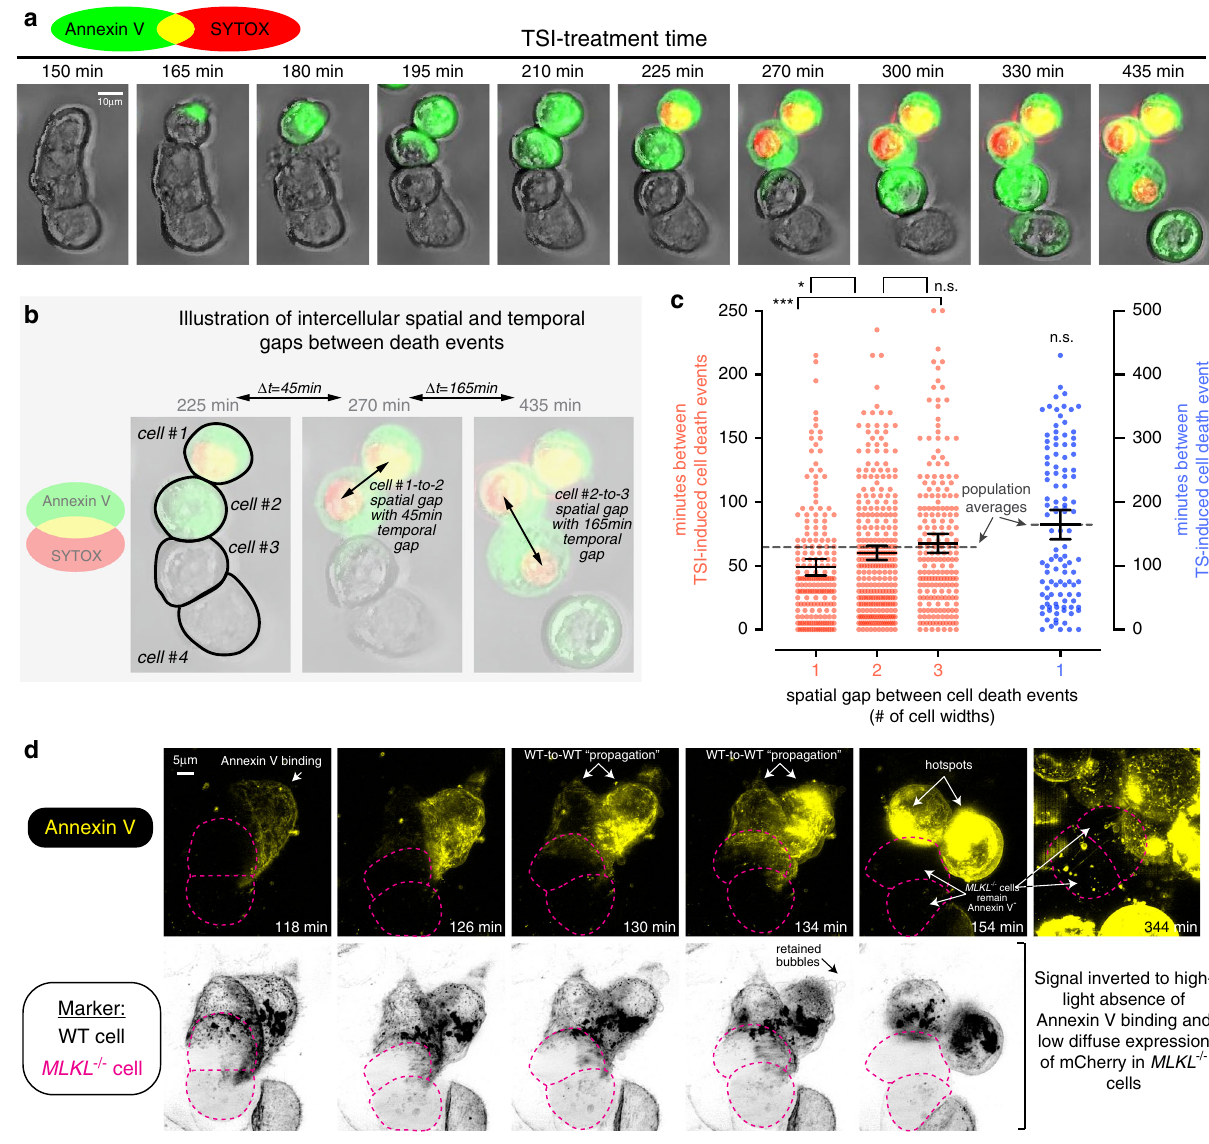
Fig. 5 Necroptosis is accelerated between junctioned epithelial cells. a HT29 cells were TNF, Smac mimetic and IDN-6556 (TSI)-treated, then Annexin V-binding (green) and SYTOX Green-uptake (red) were imaged via time-lapse epi fl uorescence microscopy. b, c HT29 cells were treated with TSI (necroptotic stimulus) or TS (apoptotic stimulus), then propidium iodide-uptake (death) and subsequent movement of dead cells was tracked over time using the IncuCyte S3 System. d Each dot represents the spatiotemporal gap between two cell death events. Mean ± 95% con fi dence intervals; dashed line represents the average spatiotemporal gap between all cell death events across the population; n.s . p = 0.2223, * p = 0.0422 and *** p = 0.0006 via one- way ANOVA with Tukey ’ s correction for multiple comparisons. For TSI-treated HT29 cells: N = 188, 289, 298 gaps for the respective 1, 2, 3-cell-width groups and N = 22676 gaps for the whole population. For TS-treated HT29 cells: N = 110 gaps for 1-cell-width group and N = 17838 gaps for the whole population. e Co-cultures of TSI-treated wild-type (expressing mTagRFP-Membrane-1 fusion protein) and MLKL − / − (diffuse expression of mCherry) HT29 cells were imaged via time-lapse lattice light sheet microscopy (LLSM) with staining for Annexin V-binding (top row; yellow signal) and markers (bottom row; same as top row but with inverted signal). MIP micrographs are representative of N = 7 MLKL − / − cells across n = 3 independent experiments. TSI- treatment times are shown; magenta lines demarcate MLKL − / − cell Tight junction proteins and MLKL are co-traf fi cked . To deduce MLKL pS358 and three tight junction markers: JAM-A, occludin and the nature of the membrane-associated MLKL pS358 puncta and ZO-1 (Fig. 8a and Supplementary Fig. 4b). Colocalization between hotspots that form during necroptosis, we co-stained HT29 cells MLKL pS358 and tight junction markers was also observed in undergoing necroptosis for MLKL pS358 and various junction, HCC2998 cells undergoing necroptosis (Supplementary Fig. 4c). organelle or microdomain markers. Negligible colocalization was Strikingly, ZO-1 colocalized with MLKL pS358 both at hotspots and intracellular puncta, suggesting that MLKL is co-traf fi cked with observed between MLKL pS358 and markers of desmosomes (Des- moglein-2), adherens junctions (E-cadherin), endosomes and tight junction proteins to the plasma membrane during necroptosis caveolae (Flotillin-1), mitochondria (TOMM20), lysosomes in HT29 cells (Fig. 8a). Furthermore, this colocalization was (LAMP2), proteasome (20S) or the chaperone HSP90 39 (Supple- quantitative in nature, with pixel-level proportionality observed mentary Fig. 4a). However, colocalization was evident between between the MLKL pS358 and ZO-1 immunosignals (Fig. 8b, c).